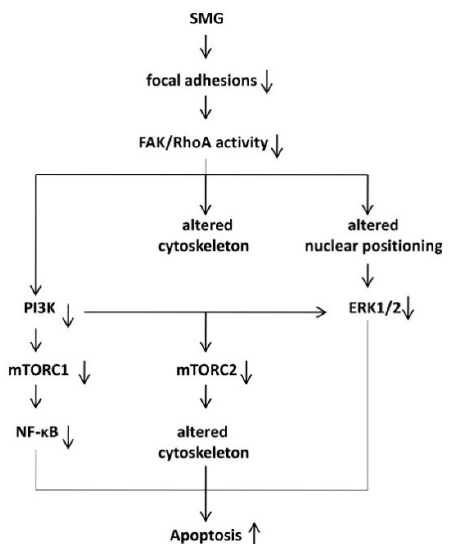
Figure 8. Schematic diagram presenting pathways where simulated microgravity reduces focal adhesions and alters the cytoskeleton and nuclear positioning, leading to enhanced cell apoptosis via suppressing FAK/RhoA-regulated mTORC1/NF-κB and ERK1/2 pathways pathways (solid up-arrows: enhance; solid down-arrows: reduce).